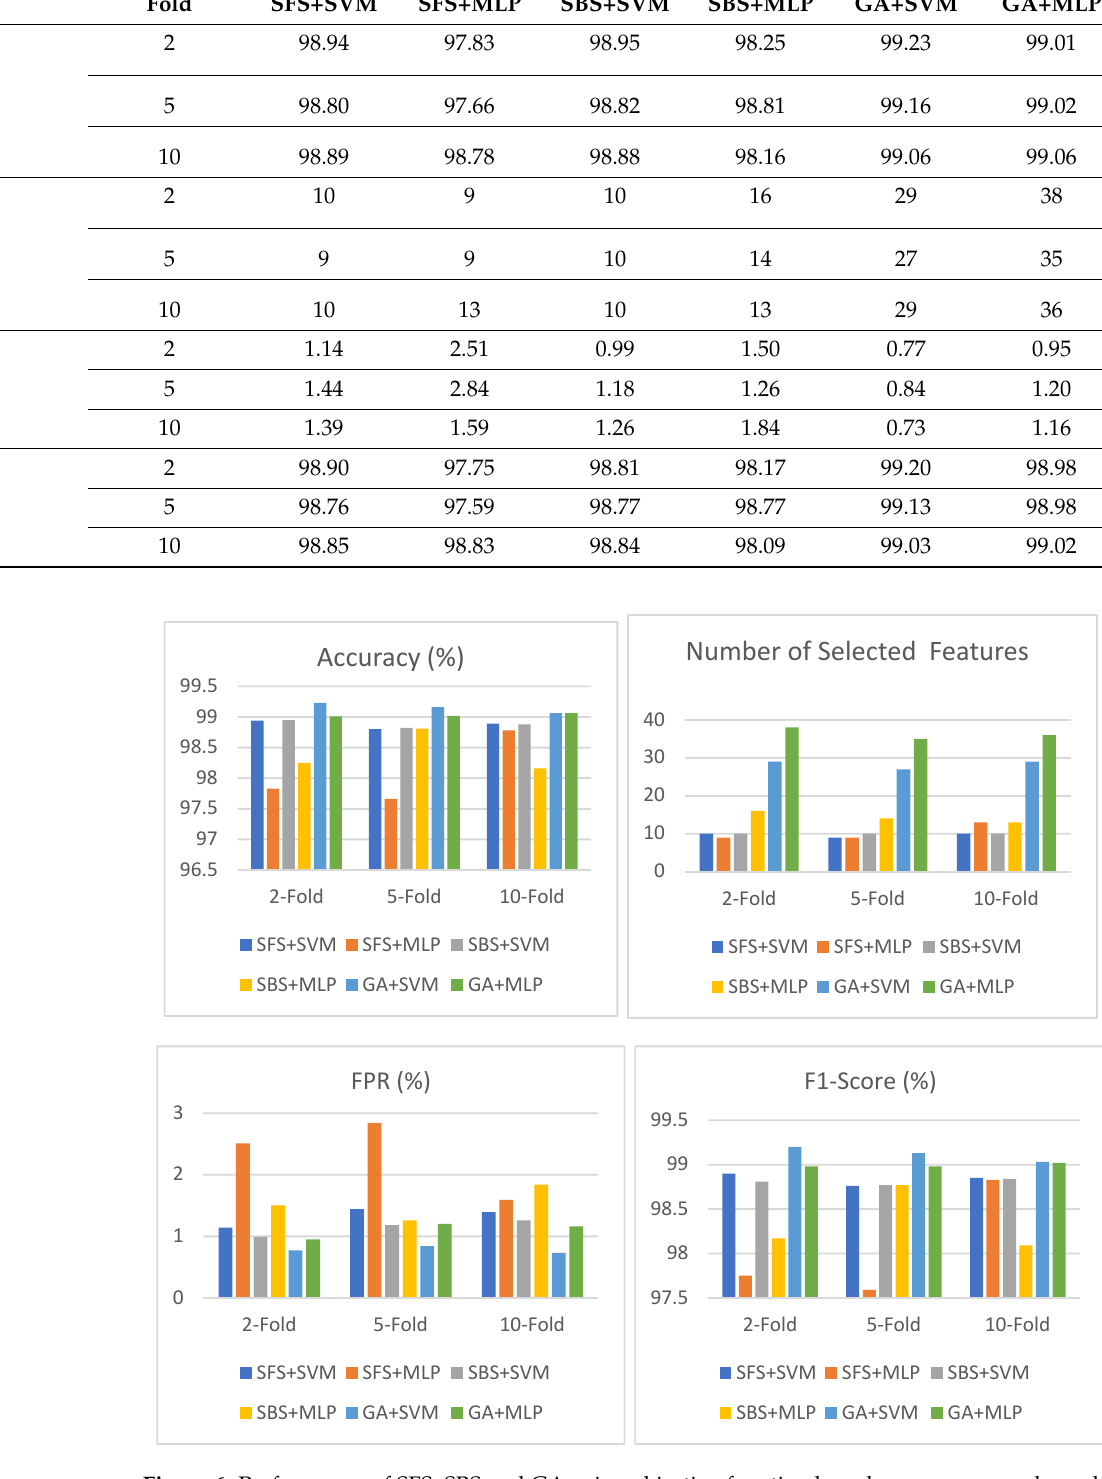
Figure 6. Performance of SFS, SBS and GA using objective function based on accuracy and number of selected features in NSL-KDD.